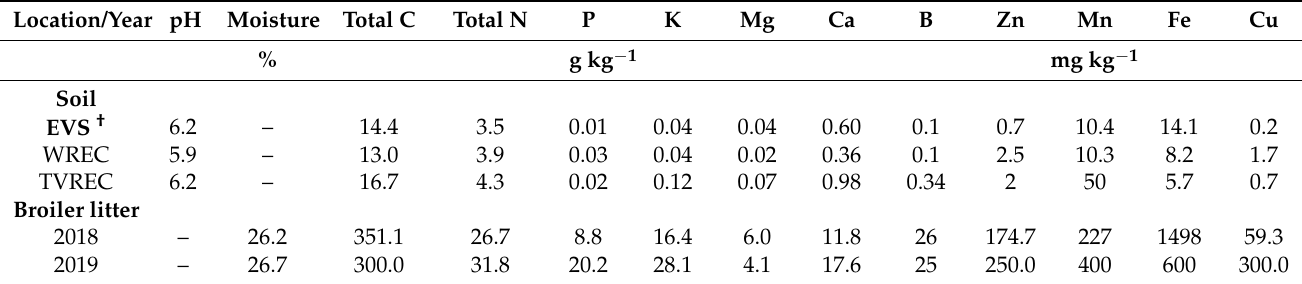
Table 1. Initial soil chemical characteristics at 0- to 15 cm depth (Mehlich 1 extraction) before experiment initiation and concentration of selected nutrients (on a fresh-weight basis) in broiler litter (BL) applied to soybean each year at the experimental sites.